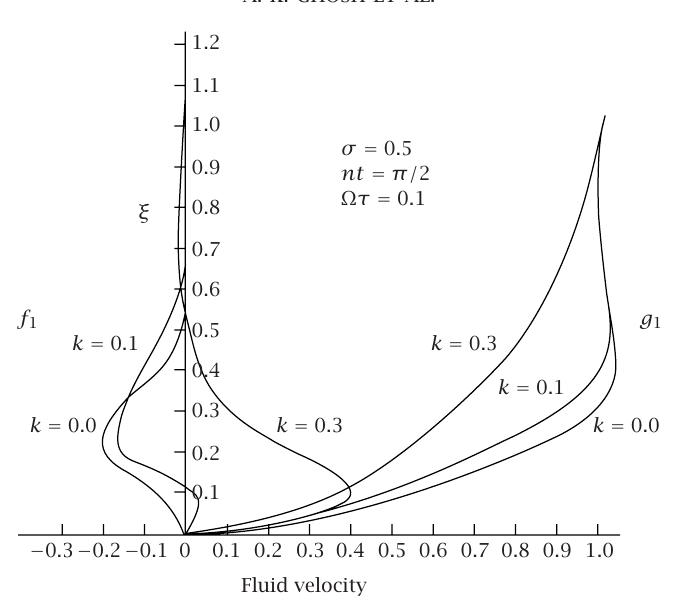
Figure 4.1 . Variations of f 1 and g 1 for different values of particle concentration k and for fixed values of nt and Ω τ when σ < 1.